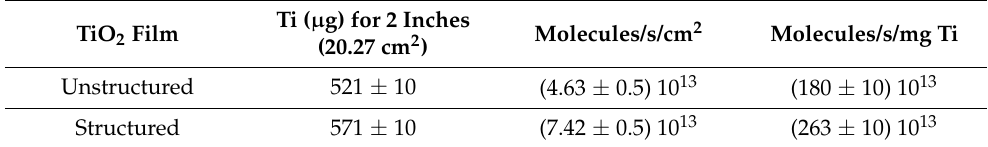
Table 2. Comparison of micro-nanostructured and unstructured